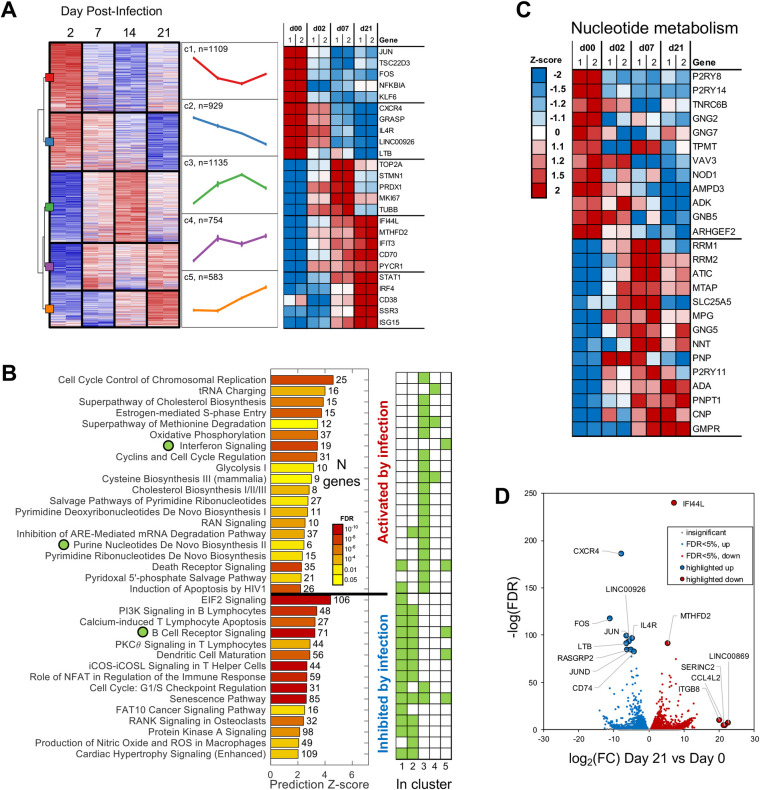
Transcriptomic analysis of EBV-mediated B-cell reprogramming.Analysis of gene expression changes over the time course of infection was performed by RNA-seq and differentially expressed genes at any time point were identified. (A) Unsupervised clustering of differentially expressed genes with representative mean expression pattern is shown for each cluster. The top 5 most changed genes along with their respective relative expression levels are also shown for each cluster. (B) Pathways significantly enriched among all differentially expressed genes. Pathways significantly enriched within specific gene clusters are indicated. (C) Relative expression level of genes associated with the nucleotide metabolism pathway. (D) Volcano plot showing differentially expressed genes at Day 21 post infection with examples of genes continuously differentially expressed across the time course highlighted.